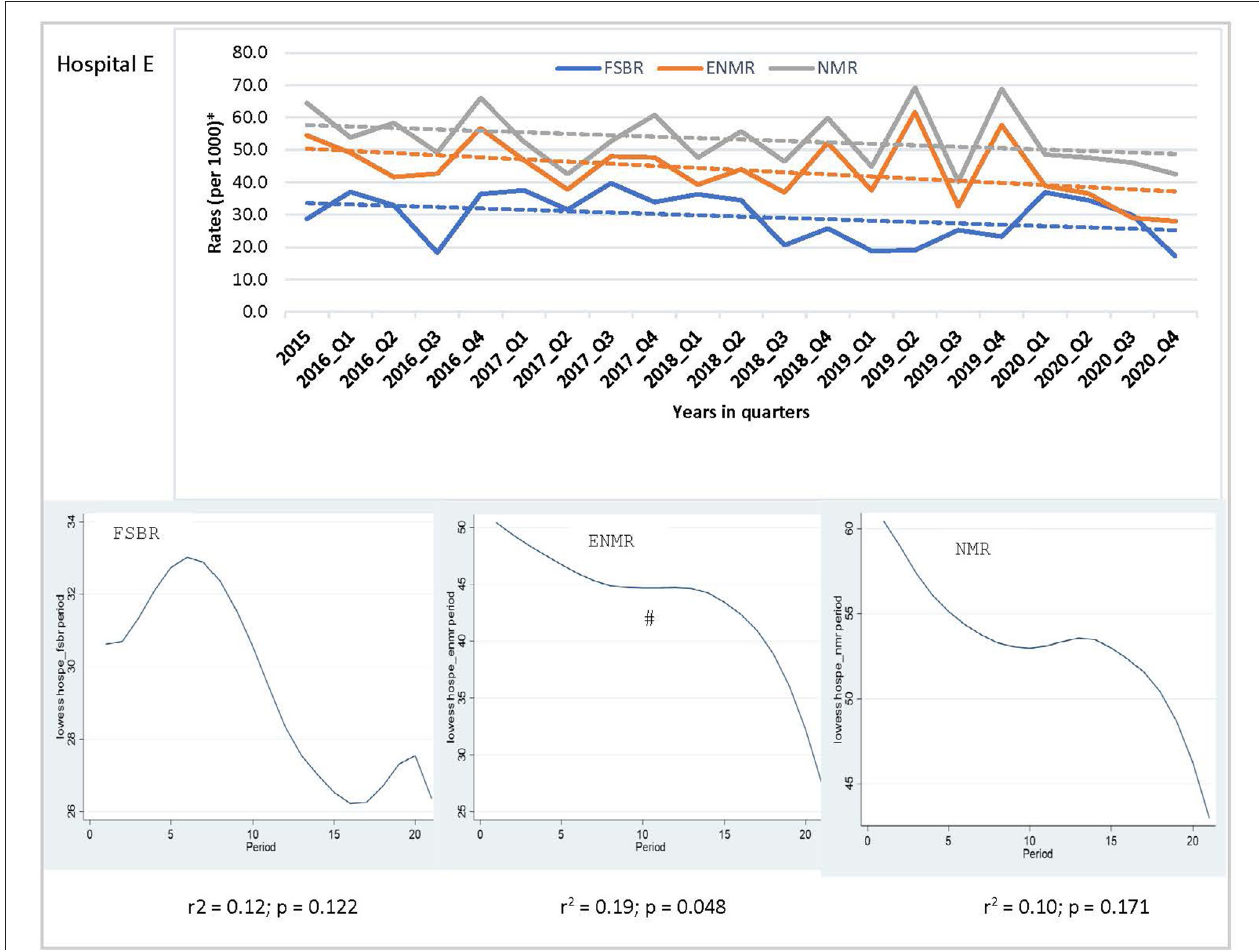
FIGURE 5 | Trends in fresh stillbirth rate (FSBR), early neonatal mortality rate (ENMR), and neonatal mortality rate (NMR), with locally weighted scatterplot smoothing (LOWESS) regression analysis in the lower panel of the Figure for tertiary hospital (Hospital E). # Statistically significant reduction ( p < 0.05). * Per 1,000 total births for fresh stillbirth rates (FSBR) and per 1,000 live births for early neonatal mortality rate (ENMR) and neonatal mortality rate